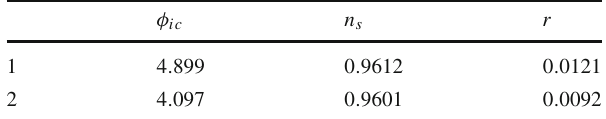
Table 2 Initial conditions for the field for the Eqs. (3.7) and (3.9) and the prediction of n s and r φ ic n s